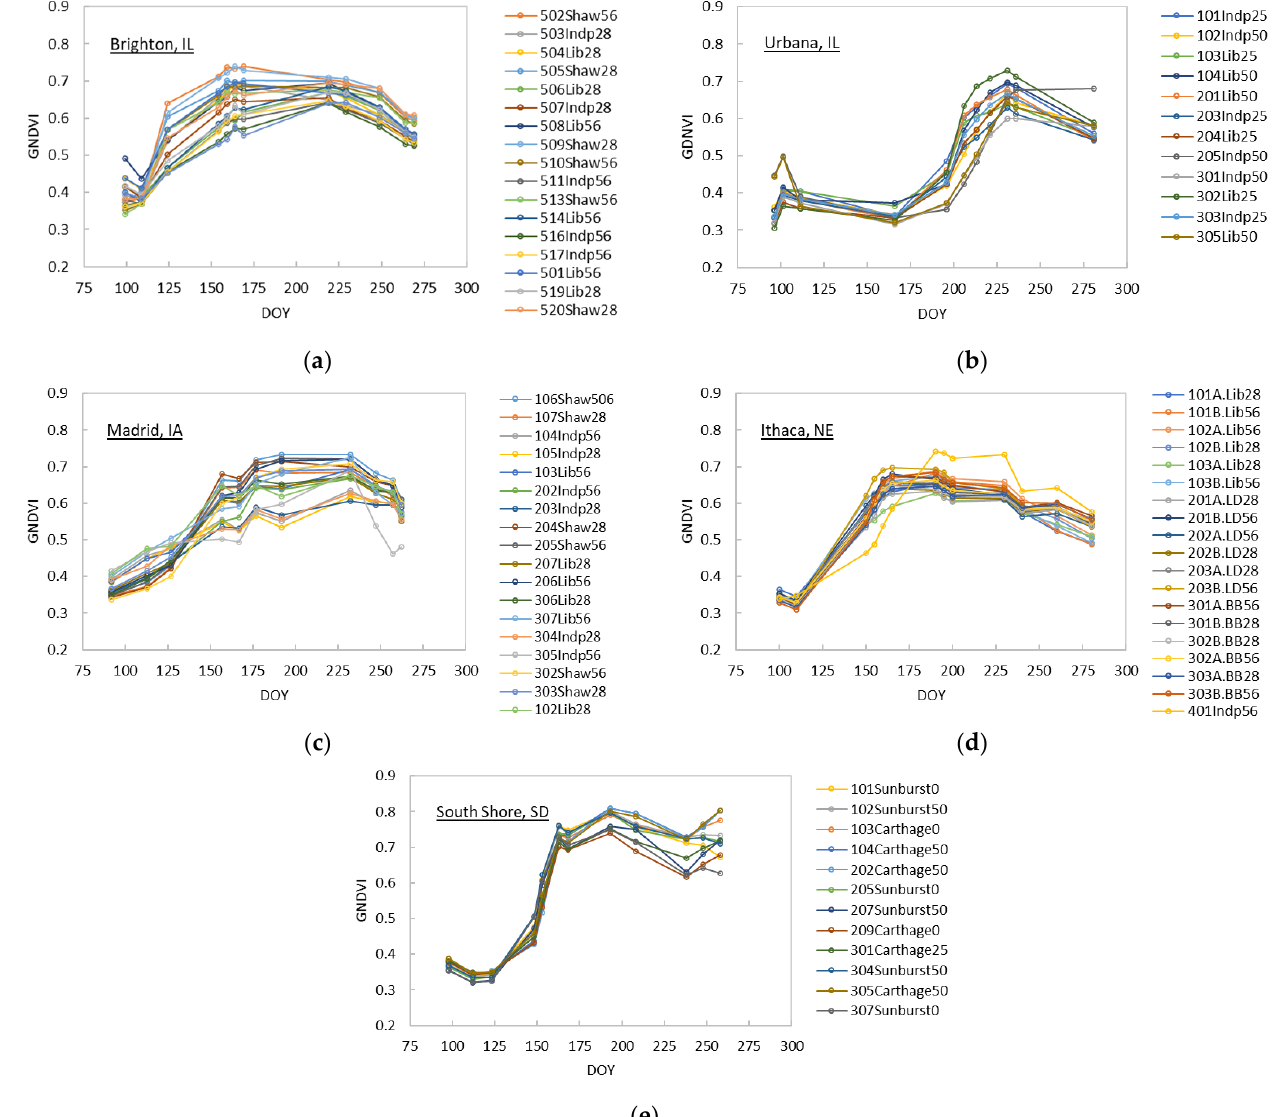
Figure 4. Seasonal trajectories of the green normalized difference vegetation index (GNVDI) by switchgrass cultivars and mixed tallgrass between April and October 2020 across the ( a ) Brighton, Illinois (IL); ( b ) Urbana, IL; ( c ) Madrid, Iowa (IA); ( d ) Ithaca, Nebraska (NE); and ( e ) South Shore, South Dakota (SD), sites. Plot legends are named based on the combination of plot number, cultivar planted, and nitrogen (N) fertilization rate (kg N ha −1 ). Switchgrass (SW) cultivars: Lib = ‘ Liberty ’ SW, Shaw = ‘ Shawnee ’ SW, Indp = ‘ Independence ’ SW, Cart = ‘ Carthage ’ SW, and Sunb = ‘ Sunburst ’ SW. Mixed tallgrass: LD = low diversity mixture, BB = big bluestem mixture. DOY = day-of-year.